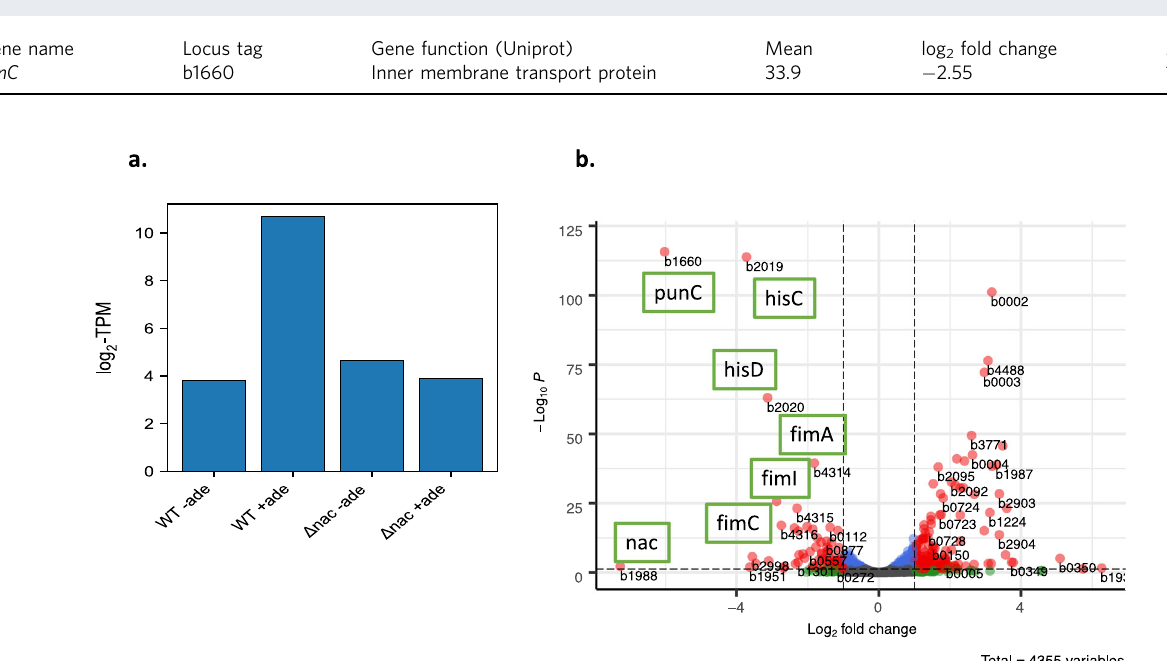
Fig. 4 RNA-Seq analysis for punC mRNA expression. a E. coli MG1655 and the nac mutant were grown in M9 medium in the absence or presence of 10 mM adenine. b mRNA differential expression for the nac mutant and wild-type in E. coli MG1655. Volcano plot comparing the log-fold expression change of genes against the adjusted p-value for the nac mutant and WT MG1655 grown at M9 supplemented with 10 mM adenine. Genes in red dots are differentially expressed. punC (b1660) is the gene with the strongest expression change in addition to hisG (b2019) and hisD (b2020) histidinol dehydrogenase (L-histidine biosynthesis), fi mA (b4314), fi mI (b4315) and fi mC (b4316).